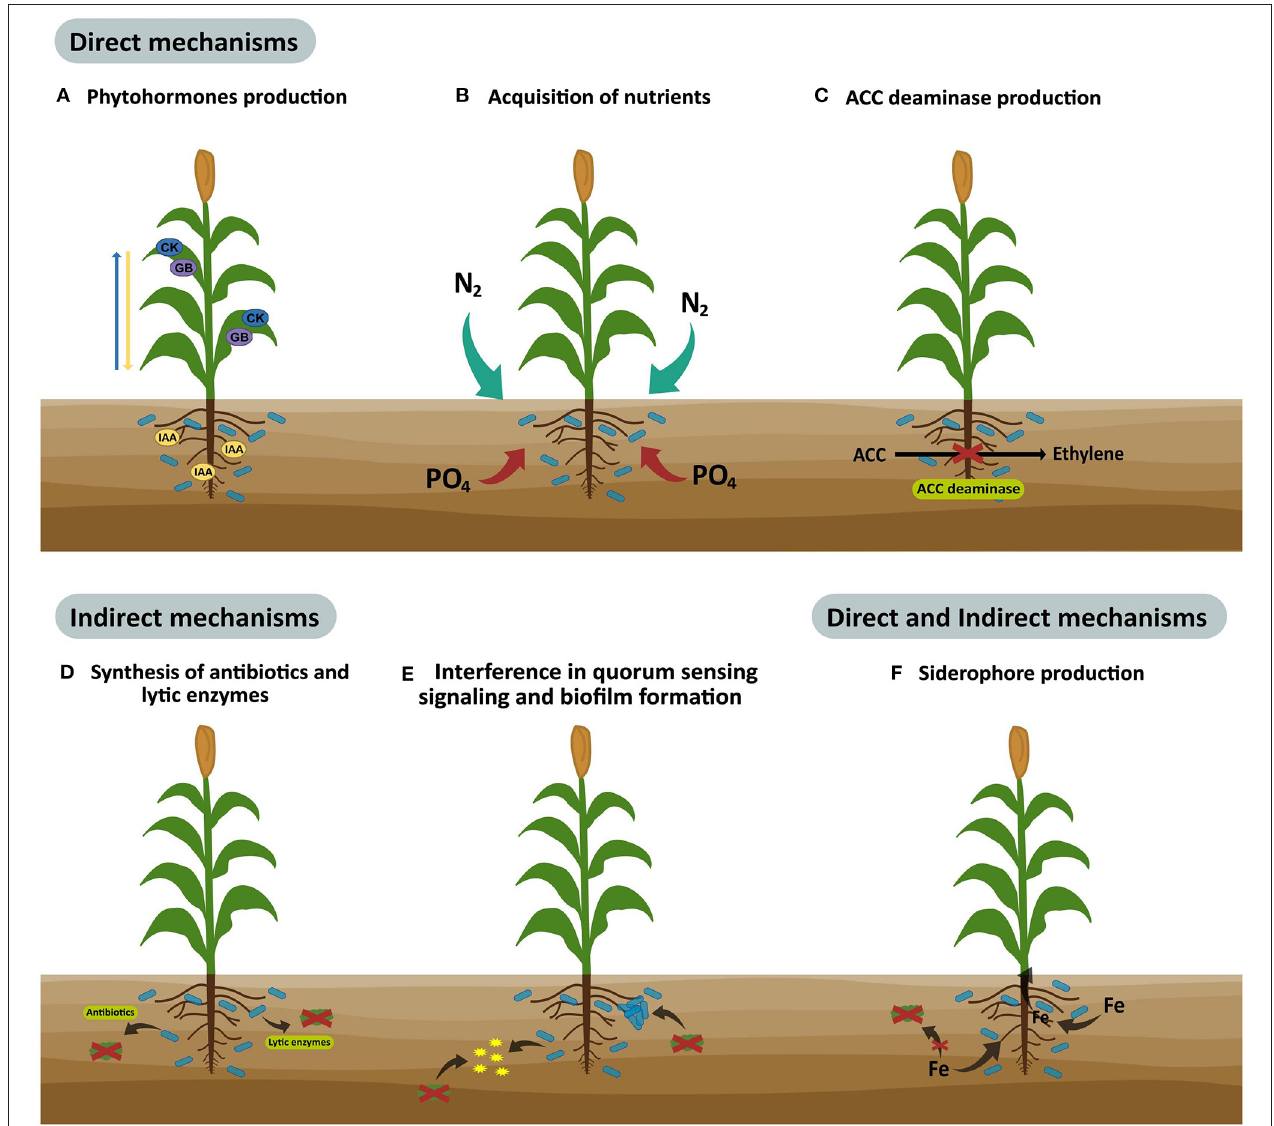
FIGURE 1 | Direct, indirect, or dual mechanisms used by plant growth-promoting microorganisms to improve crop yield and